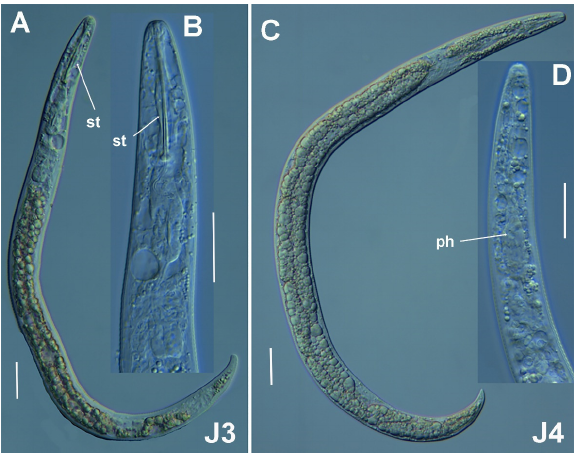
Figure 6. Micro-photomicrographs of Paratylenchus plesiostraeleni sp. nov. third- and fourth-stage juveniles. ( A ) Whole third-stage juvenile showing stylet (arrowed); ( B ) Pharyngeal region showing stylet (arrowed); ( C ) Whole fourth-stage juvenile showing absence of stylet and few developed pharynxes (arrowed). ( D ) Pharyngeal region of fourth-stage juvenile showing non-functional pharynx. Scale bars ( A – D = 20 μ m). (Abbreviations: ph = pharynx; st = stylet).